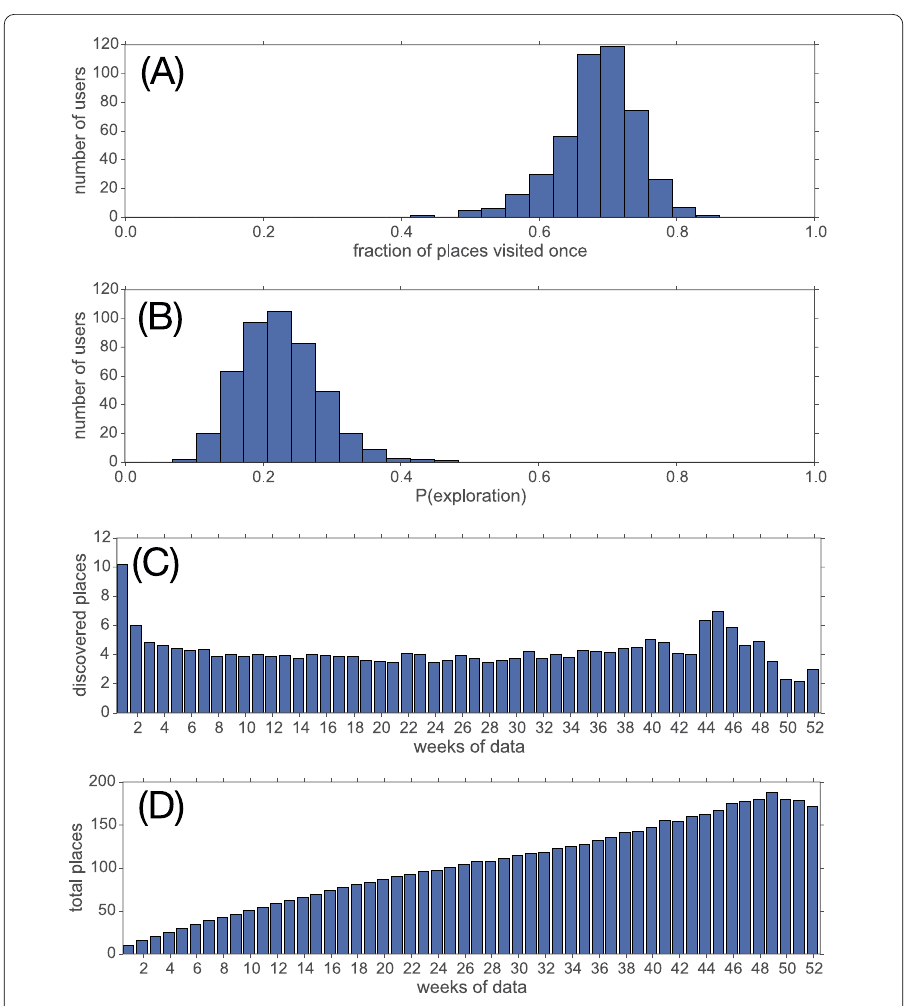
Figure 6 (A) For each user we measure the fraction of places visited only once. This fraction is surprisingly large, as for each user on average 70% of the places were visited only once. (B) The probability of exploration estimated as fraction of explorations over the number of stops per user. This probability is quite large, meaning that on average users discover a new place every 4 or 5 stops. (C) Number of new visited (explored) places for each week, average by user. Surprisingly, the number of explored places does not decrease over time, but remains around 4. This highlights the highly exploring behavior of our population. (D) Cumulated number of new visited (explored) places for each week, average by user. As consequence of the large amount of exploration, the number of possible places to visit increases steadily over time, reaching on average almost 200 in one year. (E) Exploration prediction: f 1 score for all